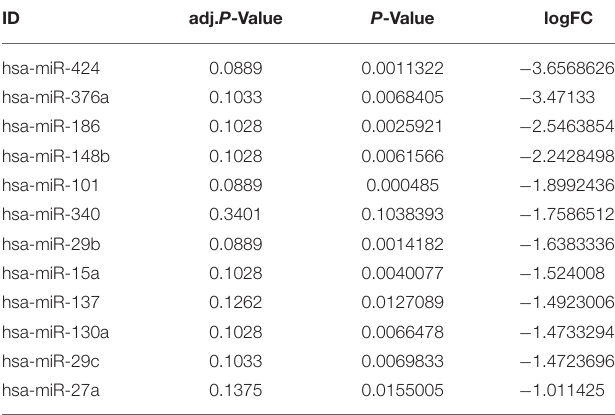
TABLE 10 | The top significant common genes in GSE16759 and our AD-associated miRNA.